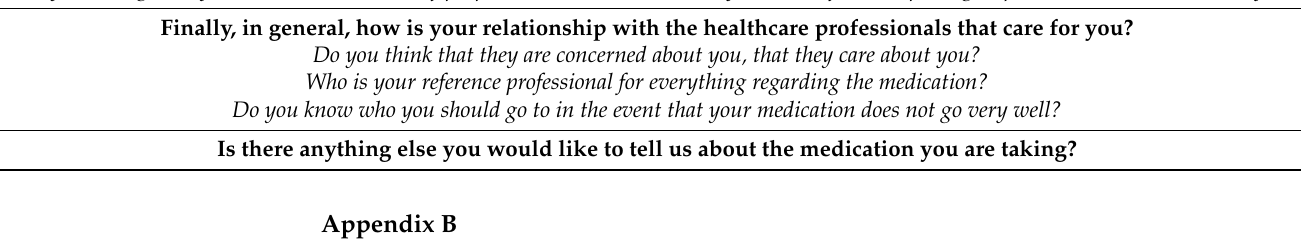
Table A2. Questionaire: Nominal Groups